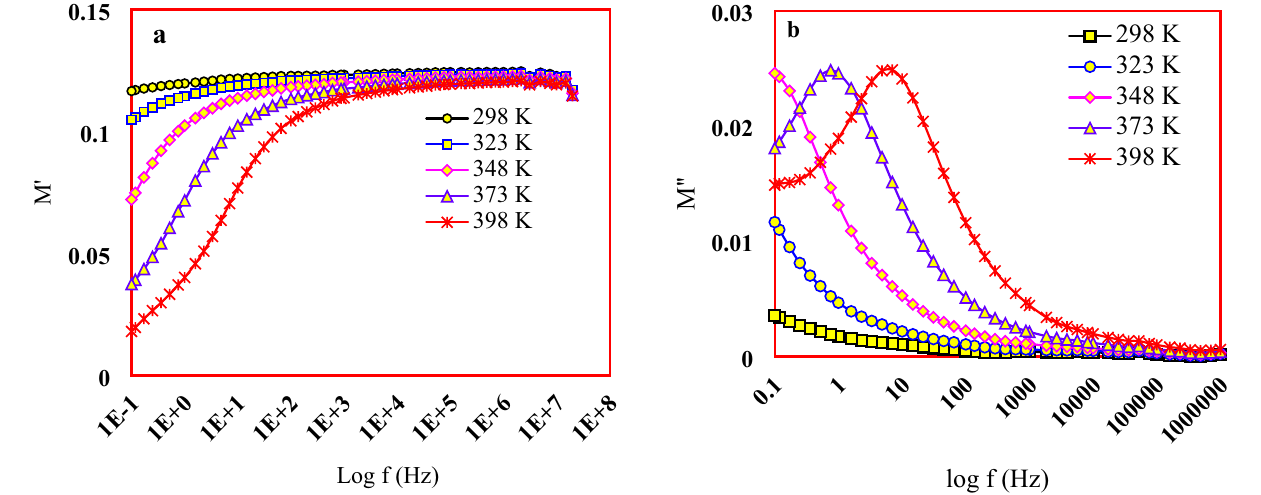
Figure 9. Dependence of ( a ) M’ and ( b ) M’’ on different temperatures and